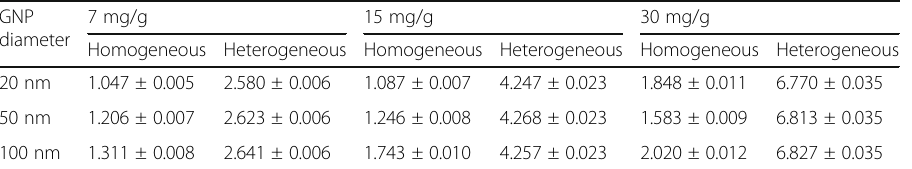
Table 2 The values of DEF calculated in the nuclei of the human eye tumor for various concentrations and diameters in homogeneous and heterogeneous distributions